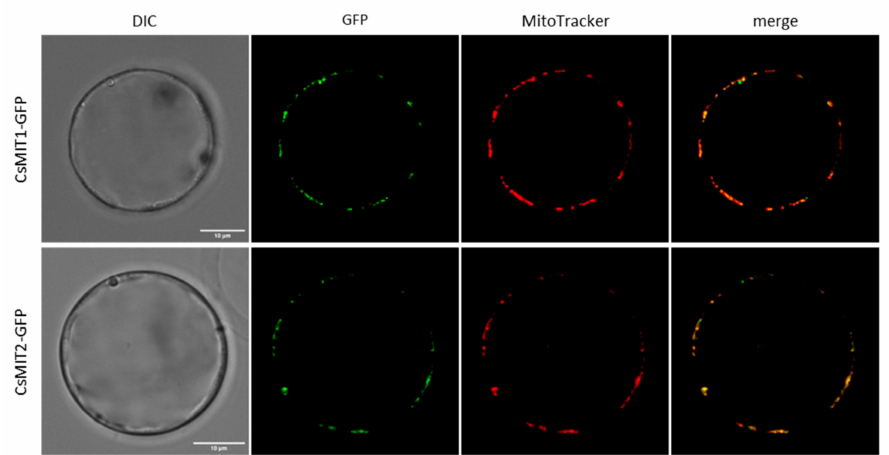
Figure 3. Subcellular localization of CsMIT1 and CsMIT2 in A. thaliana protoplasts. DIC— transmission images of the protoplasts expressing CsMIT1-GFP or CsMIT2-GFP, GFP—GFP flu- orescence of the protoplast, MitoTracker—fluorescence of mitochondria specific marker. The scale corresponds to 10 µ